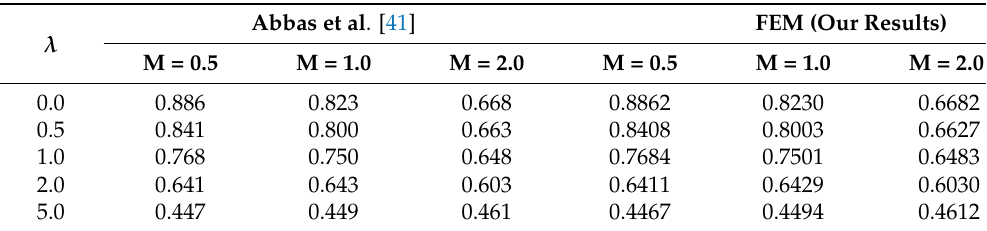
Table 6. − θ (cid:48) ( 0 ) value along with diverse values of λ at ζ = 1 and Pr = 2.0 when remaining parameters are zeros.